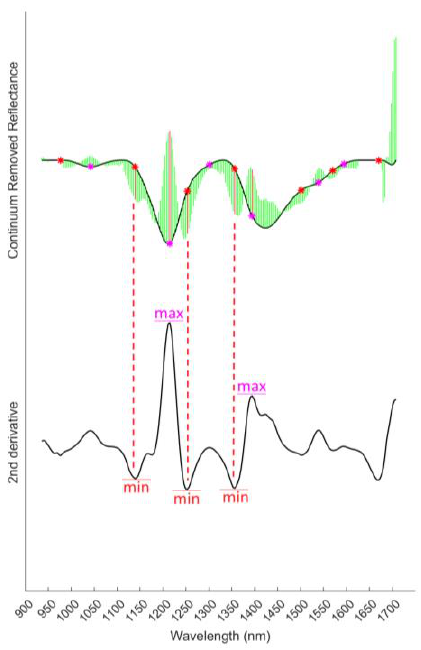
Figure 8. Use of minimum and maximum positions of 2nd derivative to select significant parameters for shape description. Parameters are the location (min/max), the curvature values at these locations (red lines) and the direction of curvature value (up for convex and down for concave behavior) [31].